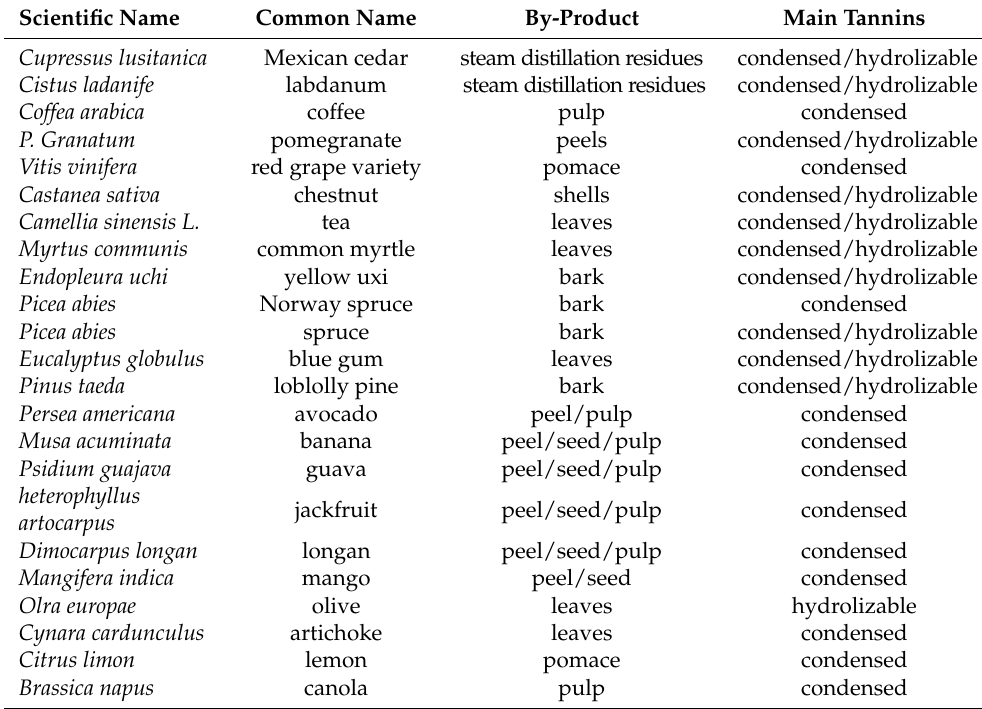
Table 3. Potential tannins’ source for animal feeding reported with their scientific name, common name, part of the plant richest in tannins and tannins’ chemical profile. Vegetal industry co-products tannins source used for ruminants